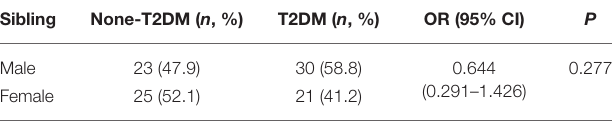
TABLE 4 | The prevalence comparison of T2DM among male and female